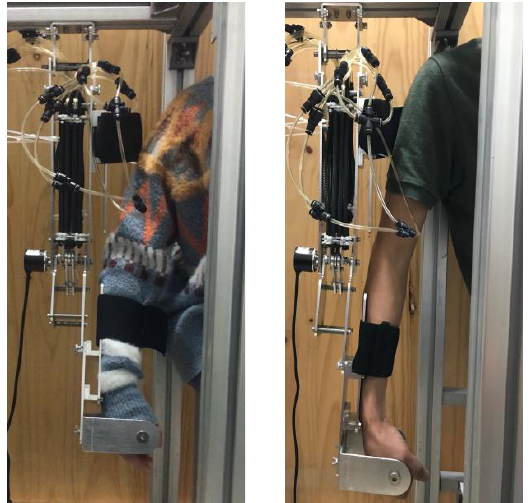
Figure 11. Effect picture of experiment subjects wearing rehabilitation robot.